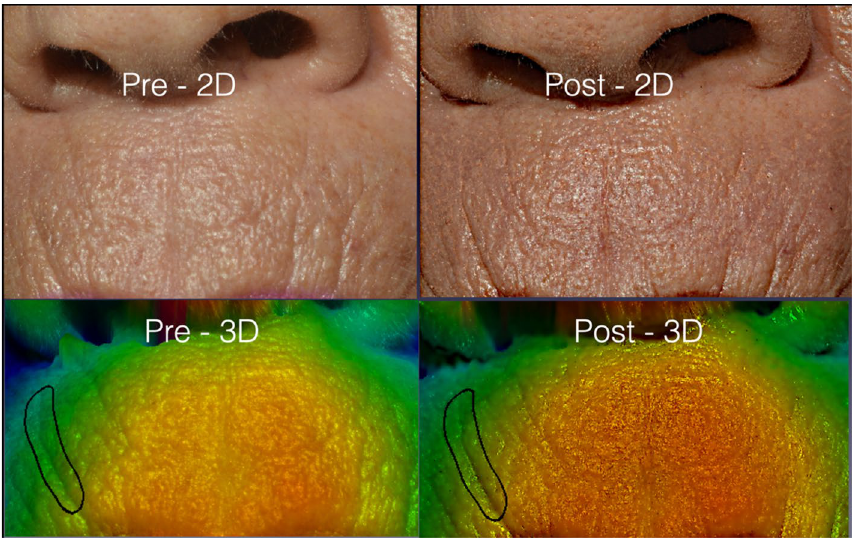
Figure 3. Patient randomised as the negative control. The black contour delimits a perioral wrinkle that has not been treated. The observers estimated an average of improvement up to 20% inside the designed area, whereas the 3D SPM system confirmed the absence of treatment.